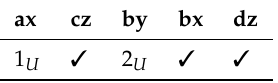
Table 8. MR-I results for uniqueness constraints